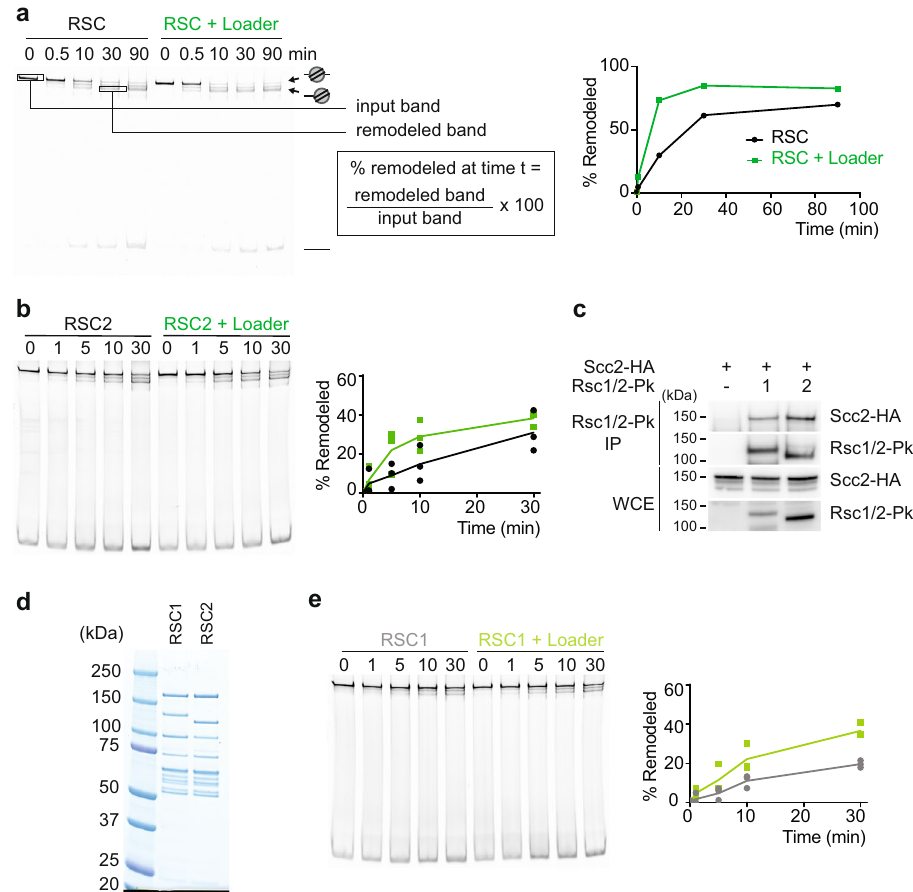
Fig. 3 | The cohesin loader stimulates RSC nucleosome remodeling. a RSC- dependent nucleosome sliding assay. Native polyacrylamide gel analysis of the nucleosome substrate and remodeled product (highlighted by arrows). The intensity of the indicated bands was quanti fi ed over time. b Three additional bio- logicalrepeatsoftheassayshownin a wereperformed.Arepresentativegelimage, as well as the quanti fi cation of each repeat are shown. A line connects the means ( p =0.0068, two-way ANOVA test). c RSC1 and RSC2 interact with the cohesin loader. Levels of both the Rsc1and Rsc2subunits inwholecell extracts (WCE), and co-immunoprecipitation (IP) of the RSC1 and RSC2 complexes with the cohesin loader (detected by an HA epitope on its Scc2 subunit) were analyzed